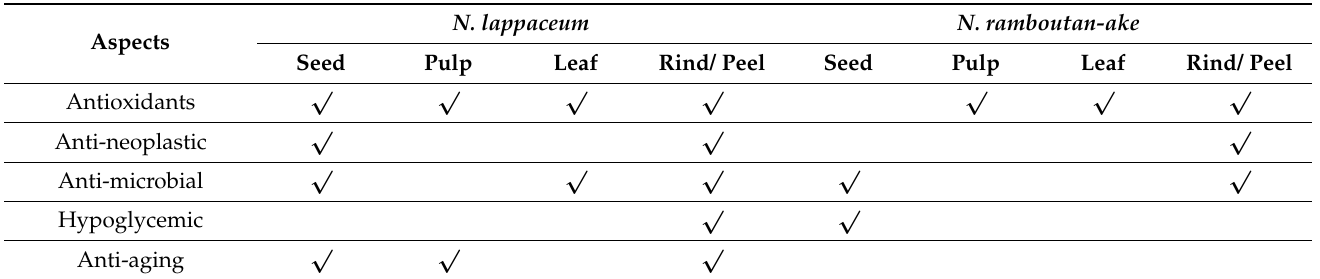
Table 7. A comparison summary of studies conducted on N. lappaceum and N. ramboutan-ake .